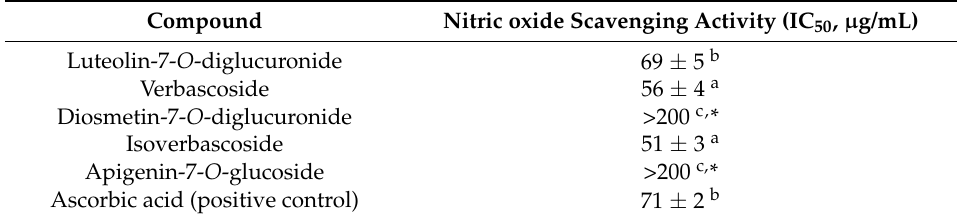
Table 2. Nitric oxide scavenging activity of major constituents from Aloysia triphylla leaves. Compound Nitric oxide Scavenging Activity (IC 50 , µ g/mL) Luteolin-7- O -diglucuronide 69 ± 5 b Verbascoside 56 ± 4 a Diosmetin-7- O -diglucuronide >200 c, * Isoverbascoside 51 ± 3 a Apigenin-7- O -glucoside >200 c,